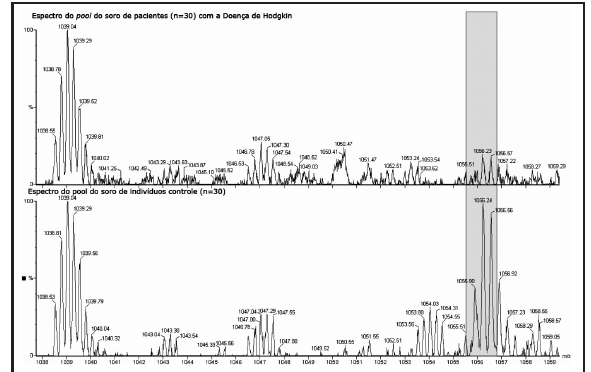
Figura 2 – Espectro de massa dos pools de pacientes com a doença de Hodgkin (superior) e indivíduos controles (inferior). O eixo y representa intensidade do sinal e o eixo x, a razão massa/carga (m/z) dos peptídeos ionizados. A janela indica os picos com intensidade diferenciada de razão m/z de 1.056 indicando a presença de um possível